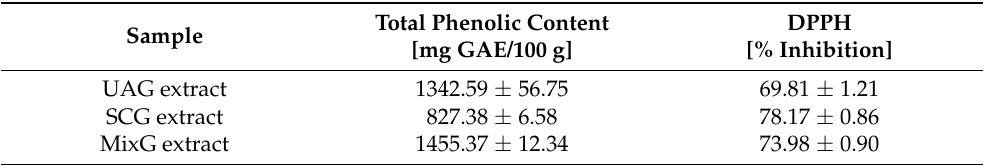
Table 2. Antioxidant activity expressed as % inhibition, and content of total phenols expressed as mg of GAE per 100 grams of an individual type of ginger extracts obtained (UAG, SCG, and mixG extracts) determined by appropriate spectrophotometric